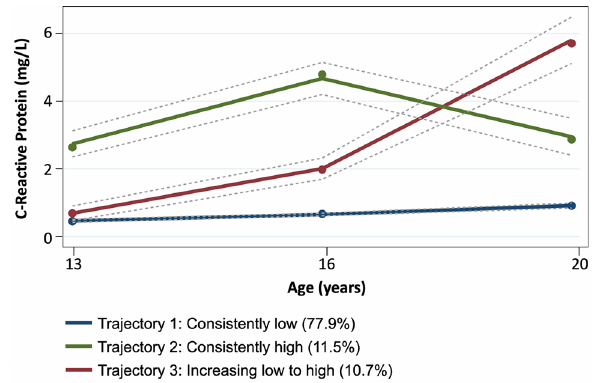
Figure 1. C-reactive protein trajectory groups with 95% confidence